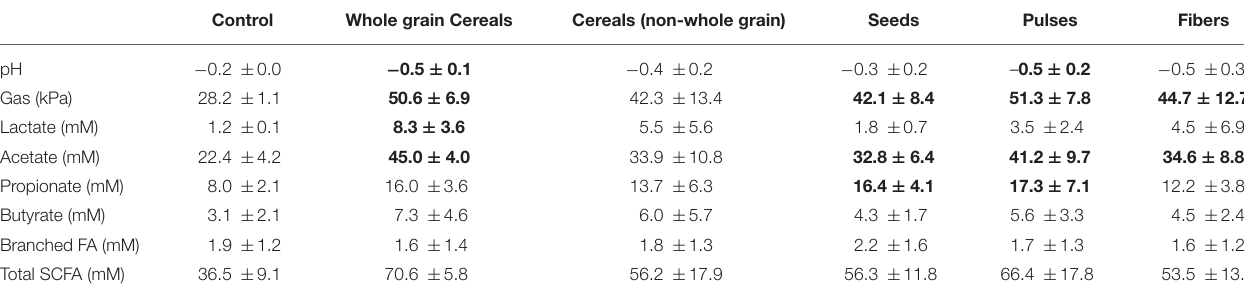
TABLE 3 | Effect of different groups of dietary fibers on bacterial metabolic markers. Control Whole grain Cereals Cereals (non-whole grain) Seeds Pulses